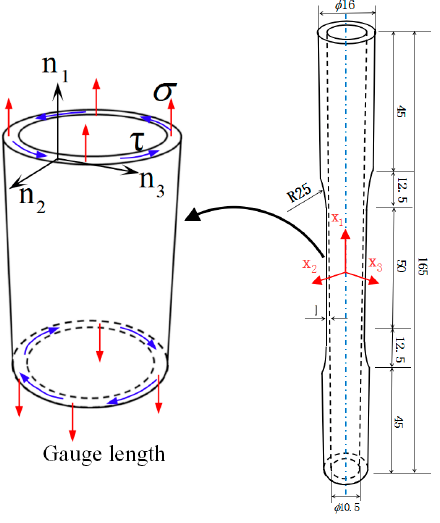
Figure 2. The geometrical figure for thin-walled tube specimens of pure aluminum (unit: mm).